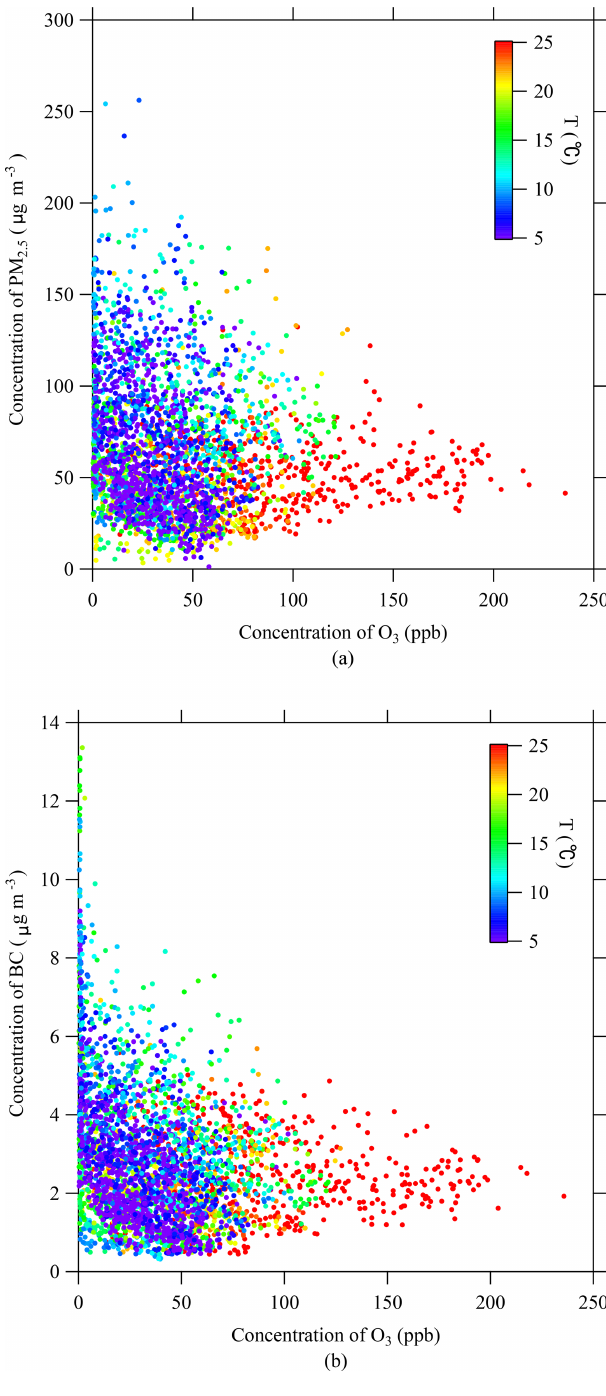
coded with air temperature ( T